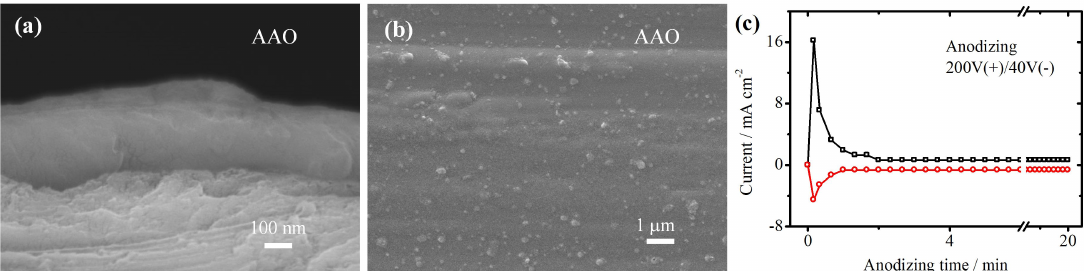
Figure 1. Morphological qualities of the AAO layer and the current density profile in anodizing. The images of ( a ) cross-sectional view and ( b ) top view for the barrier layer grown in the solution of 5.5 g · dm − 3 NH 4 B 5 O 8 · 8H 2 O. The associated ( c ) anodizing current is performed with the potentiostatic condition 200 V ( + ) / 40 V ( −